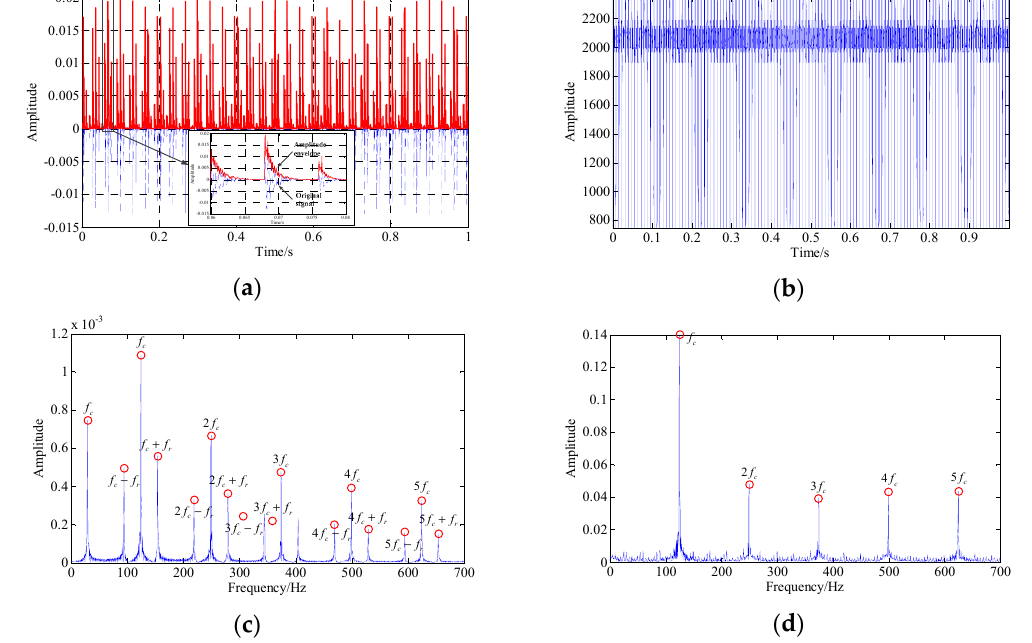
Figure 2. The amplitude envelope and instantaneous frequency of the signal shown in Figure 1: ( a ) amplitude envelope waveform; ( b ) instantaneous frequency waveform; ( c ) envelope spectrum; ( d ) instantaneous frequency spectrum.